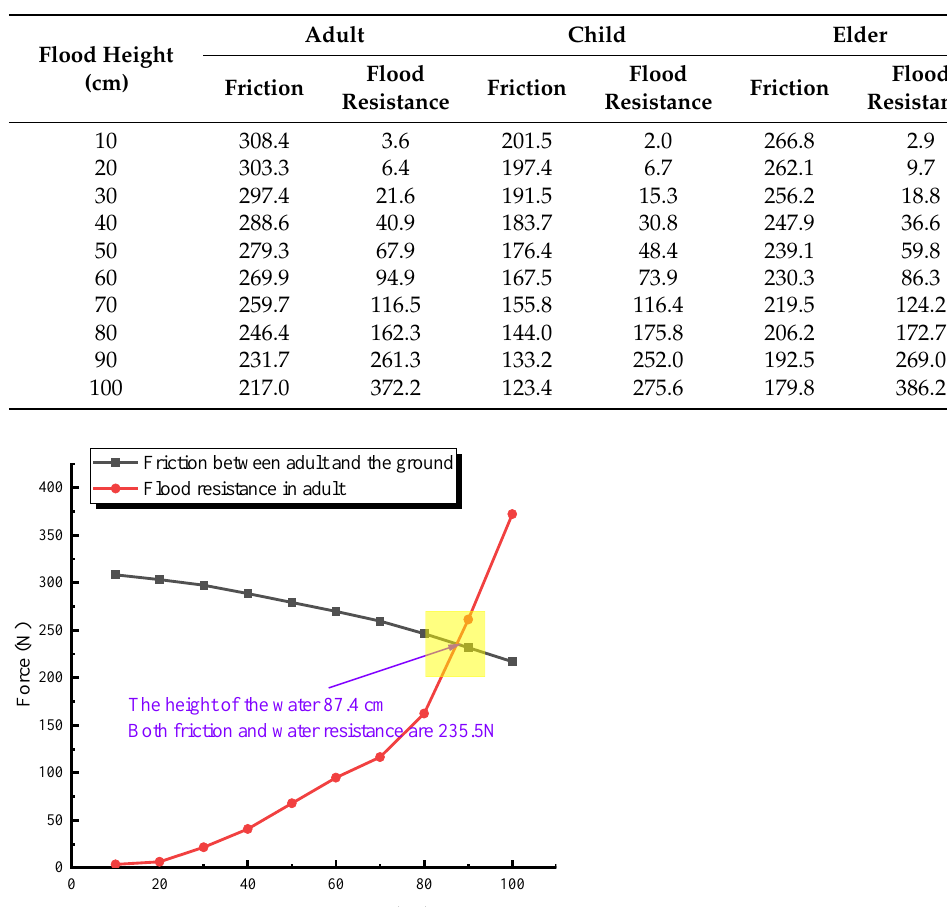
Table 11. Friction and flood resistance of all groups when walking at a critical speed at different flood heights.